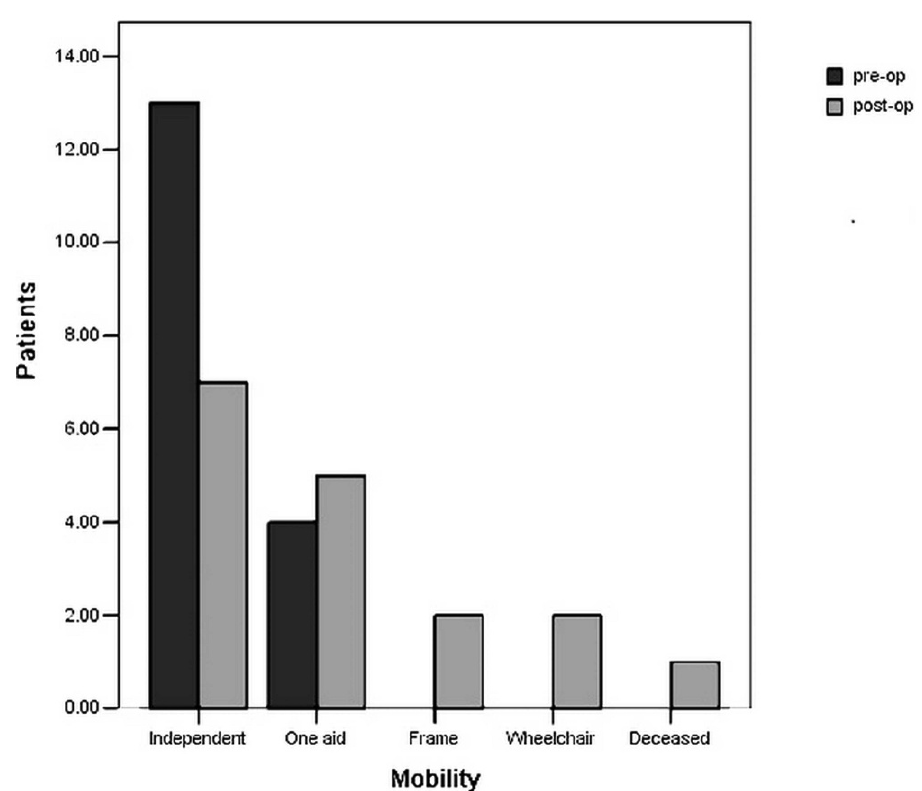
Figure 3 - Graph showing the level of patient mobility before and after the fracture.